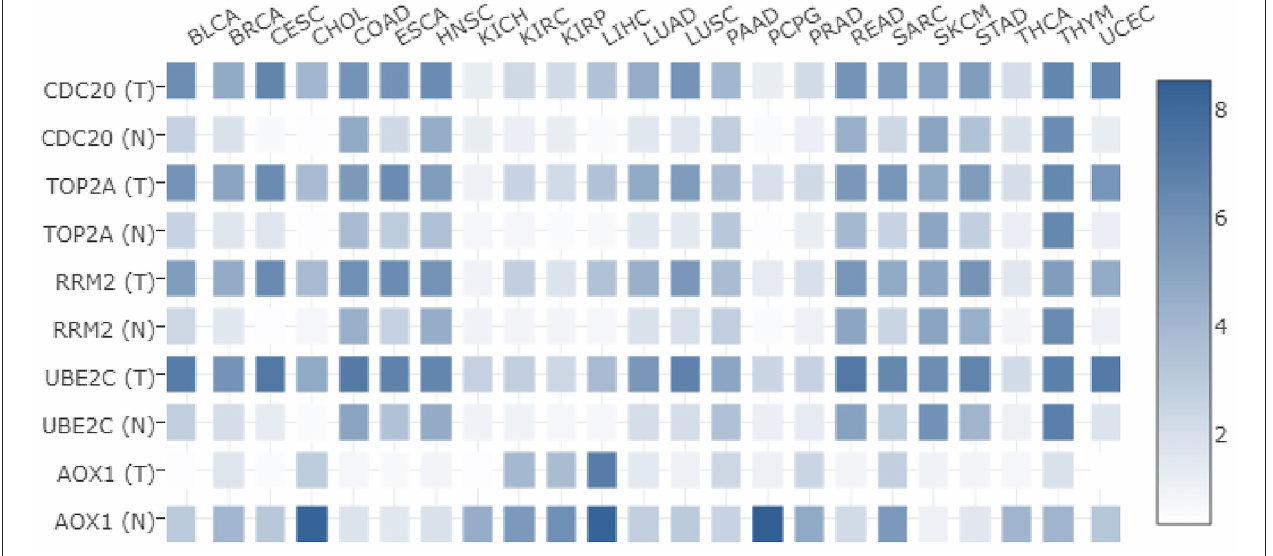
FIGURE 6 | Differential expression of five core genes in many kinds of tumors in TCGA. The X-axis represents the tumor type, the Y-axis represents the gene name. T is the tumor sample, N is the normal sample, and the histogram on the right side is the color scale.